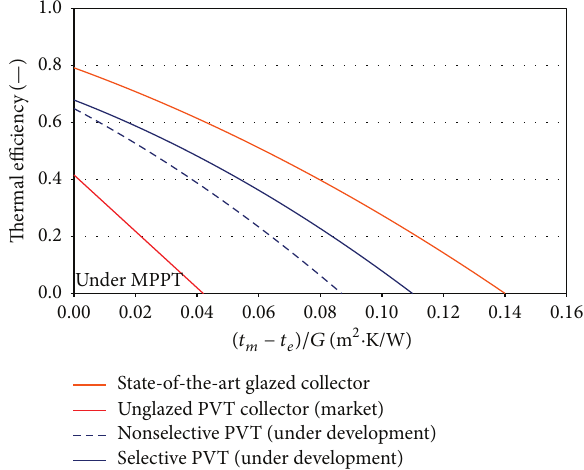
Figure 3: Comparison of thermal efficiency characteristics for glazed PVT collectors (open circuit) under development and state- of-the-art photothermal collector.